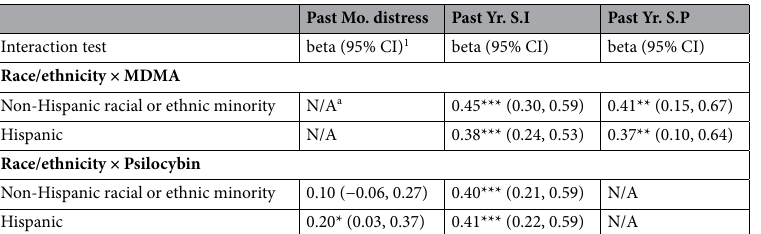
suicidal ideation, and with MDMA use for predicting past year suicidal ideation and planning. Thus, we pro- ceeded with dividing our sample by race and ethnicity and testing the associations between the aforementioned substances and all distress and suicidality outcomes.